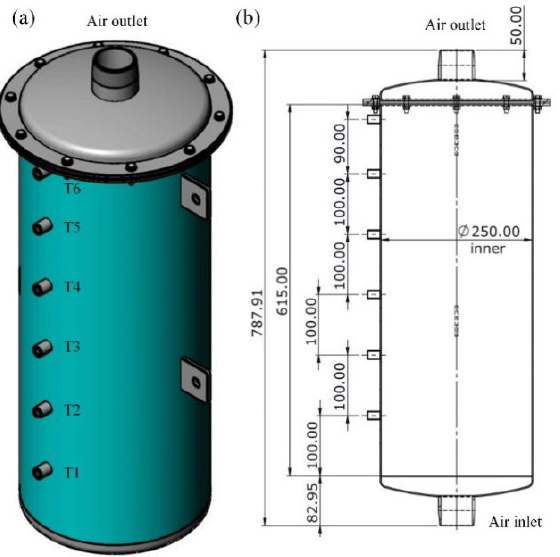
Table 1. Operating conditions for charging and charging